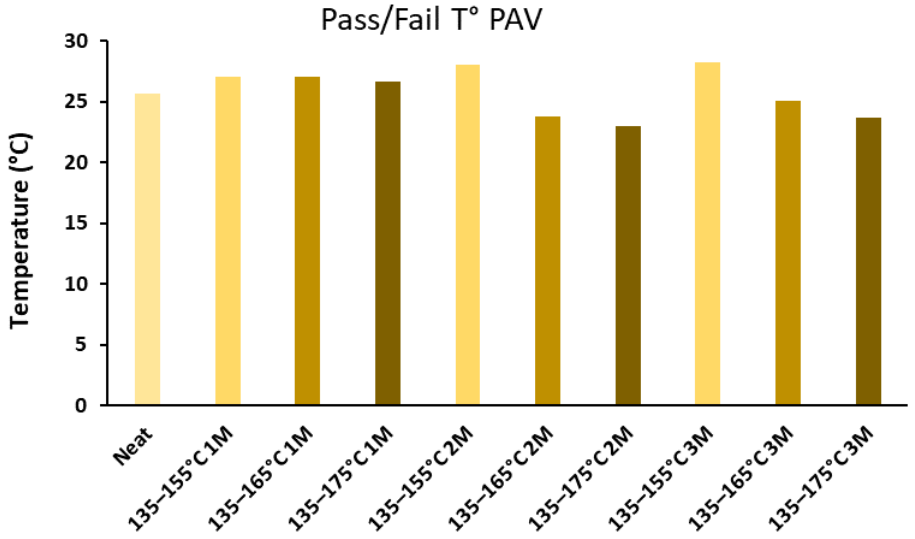
Figure 26. Fatigue cracking factor ( |G*|sin(δ) ) at the PAV-aged stage under different temperatures.